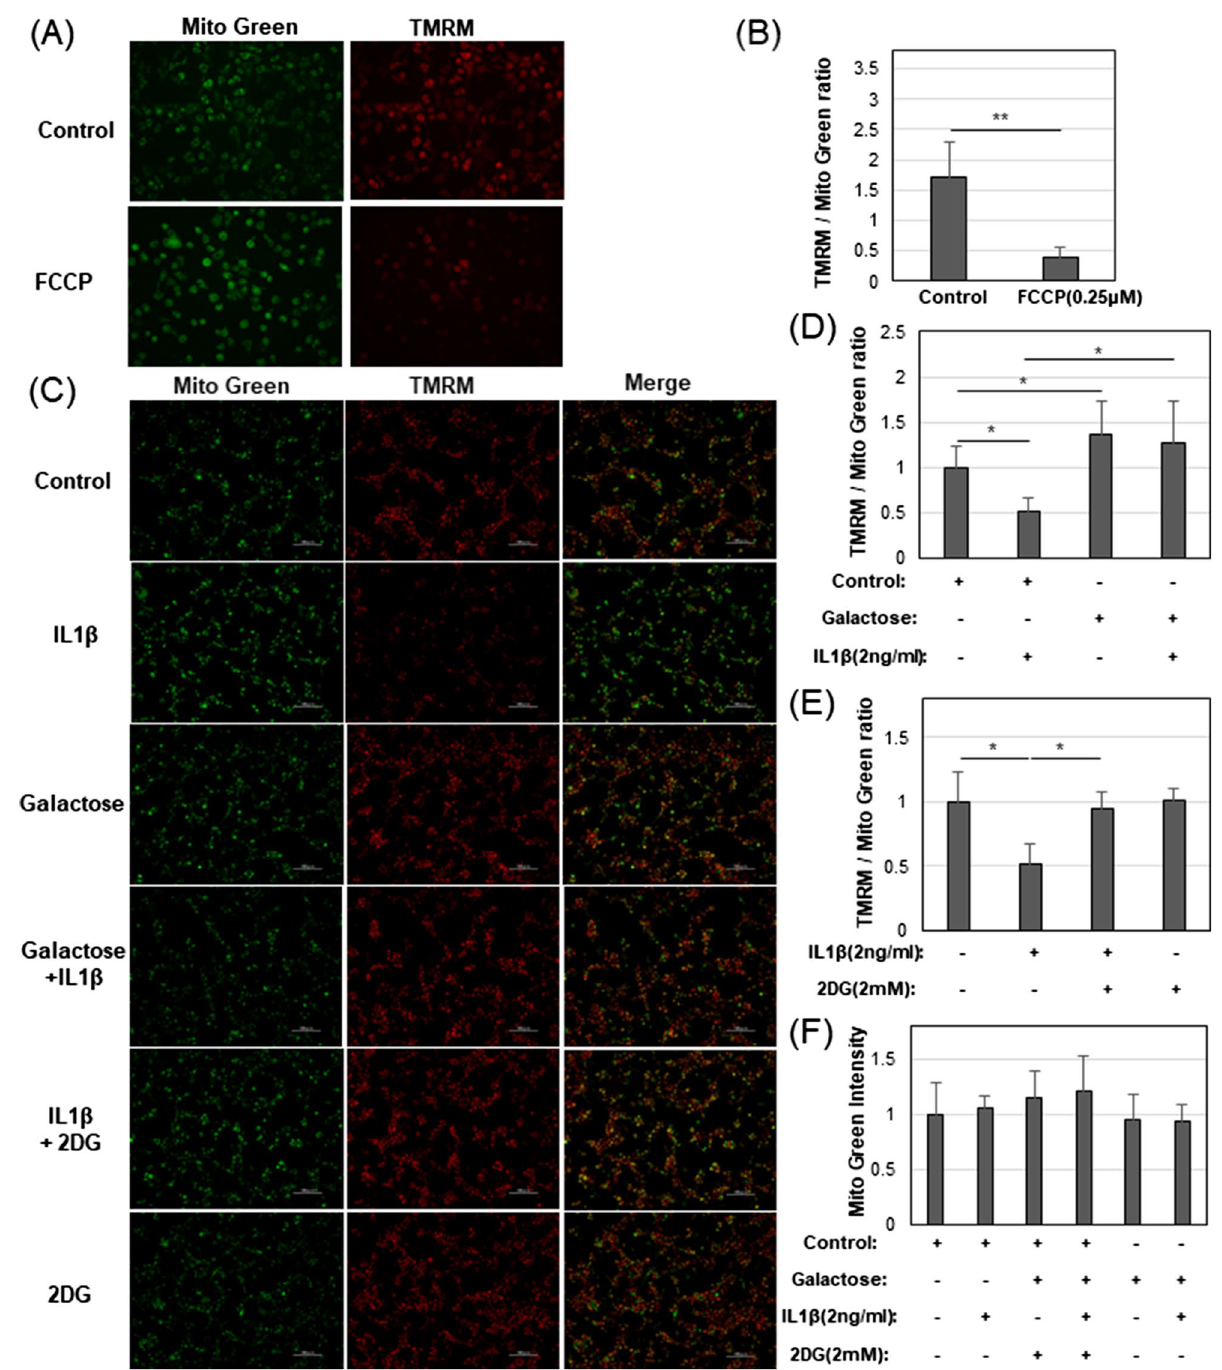
Figure 3. Effects of IL1β and galactose on mitochondrial integrity and function. ( A ) Representative images of Mito Green and TMRM stained chondrocytes in Control glucose medium without or with FCCP. ( B ) Bar graph of TMRM/Mito Green ratio without or with FCCP. ( C ) Representative images of Mito Green, TMRM, and merge in Control glucose or galactose medium with or without IL1β and 2DG as labeled. ( D ) Bar graph of TMRM/Mito Green ratio of Control, IL1β, Galactose, Galactose + IL1β culture conditions. ( E ) Bar graph of TMRM/Mito Green ratio from Control glucose, IL1β, IL1β + 2DG, and 2DG culture conditions. ( F ) Bar graph of the color intensity of Mito Green alone in the conditions labeled. Displayed images ( A , C ) are digitally enhanced to 40% brighter and processed by haze reduction. The color intensity ( B , D – F ) was calculated from raw images and bar graphs show the average ± S.D. (error bars), n = 6 experiments. Student’s t-test was used for statistical analysis in panel B. ANOVA followed by Tukey post-hoc test was used for statistical analysis in ( D – F ). *p < 0.05; **p <